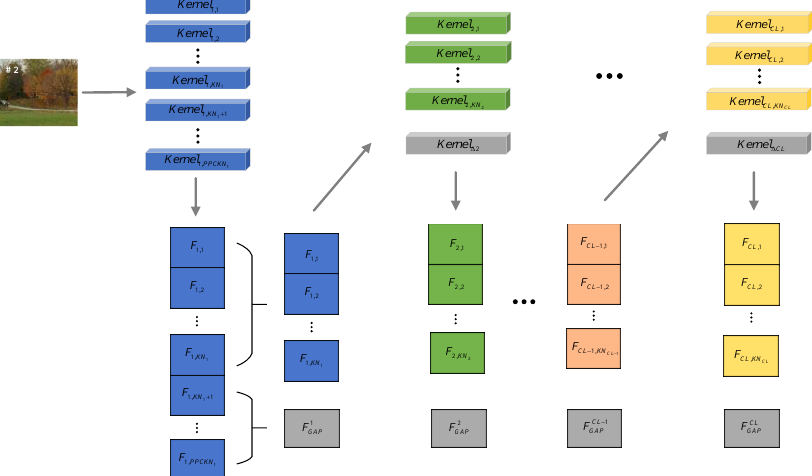
Figure 7. The deep-pruned feature network is applied to the second frame of the tracking video sequence for feature extraction. ( #𝑖 indicates the 𝑖 𝑡ℎ picture in the video sequence).